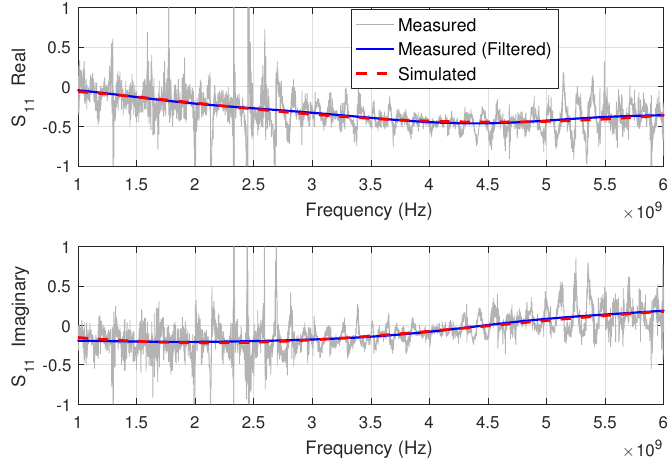
Figure 6. S 11 ( ω ) of the PMMA (simulated and measured).